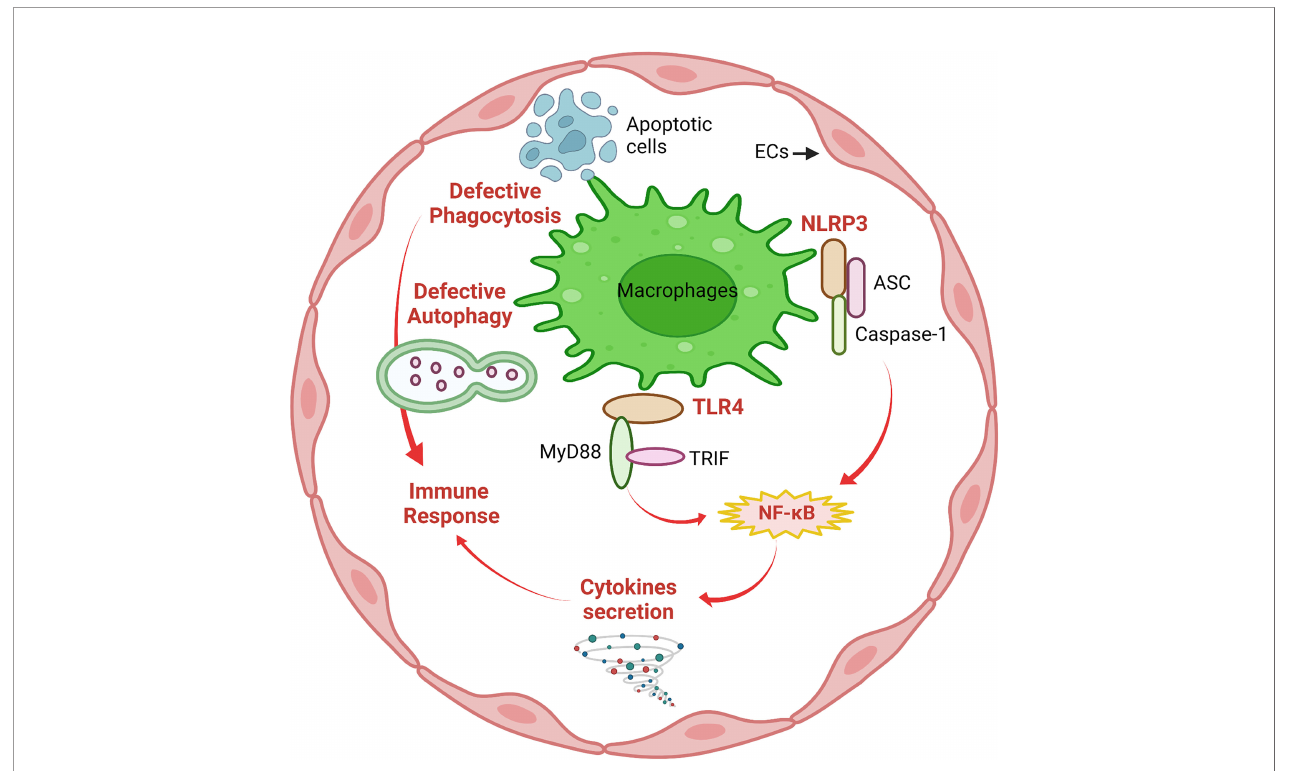
FIGURE 1 | Macrophage-like functions in ECs. Similar to macrophages, defective phagocytosis and autophagy are implicated in de fi cient immune responses of ECs. The innate immune system in ECs involves activation of NLRP3 in fl ammasome and TLR4/MyD88/TRIF signaling followed by NF- k B-mediated secretion of pro- in fl ammatory cytokines to mediate the immune response. This fi gure was created with